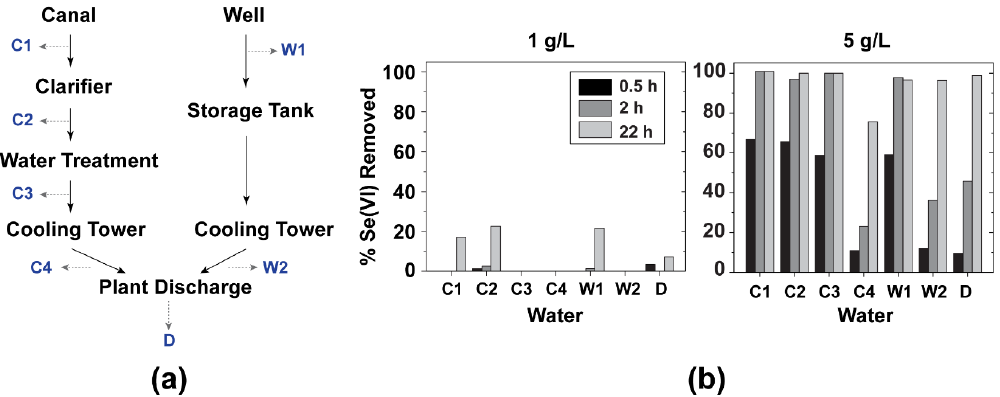
Figure 2. ( a ) Schematic showing the water sampling sites at the power plant; ( b ) Jar test results from power plant waters spiked with 0.2 ppm selenate using LDH-500C at 1 g/L and 5 g/L dosage.